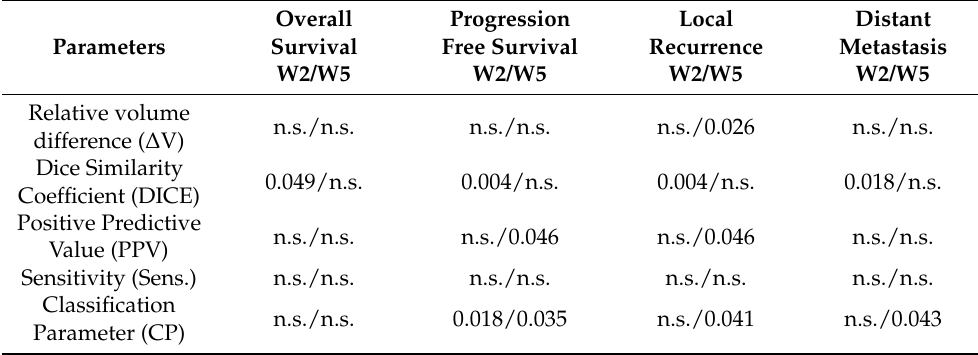
Table 2. p- Values for the prediction of the treatment response at week 2 and 5 (W2/W5) during CRT. No statistically significant prediction was represented by “n.s.”.